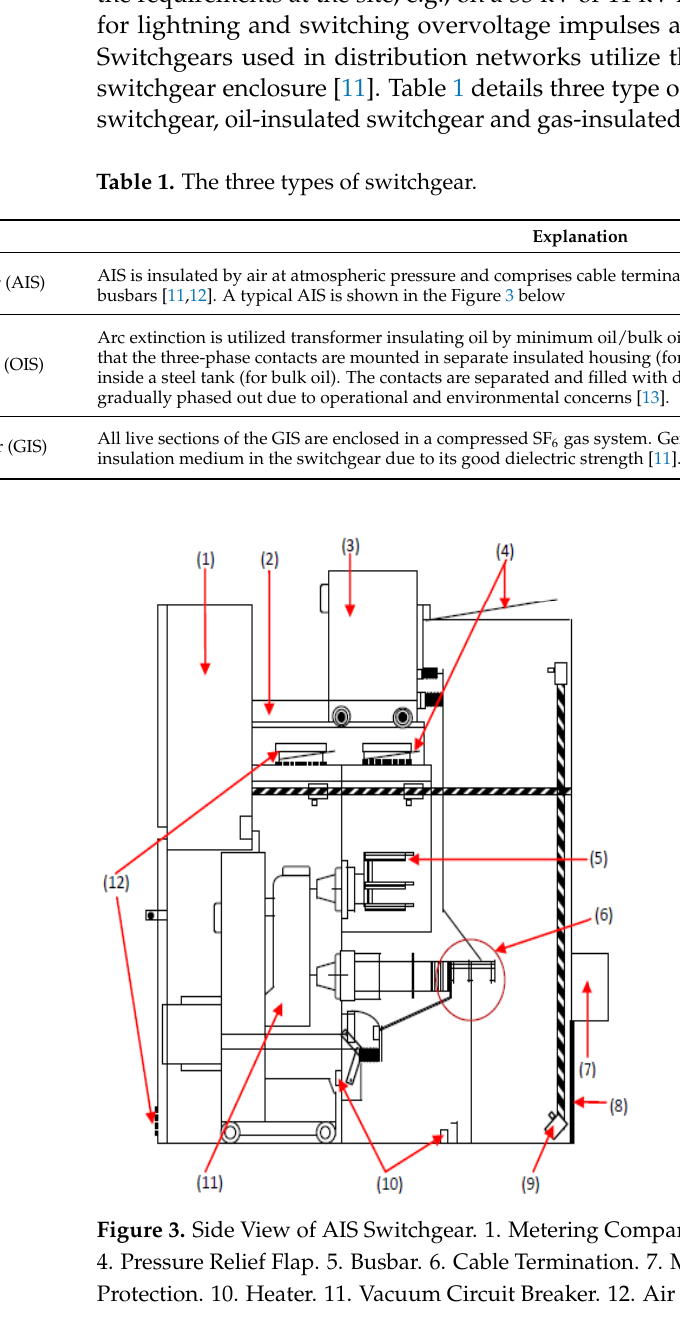
Figure 4. Sample of bulk/minimum oil circuit breaker [13].